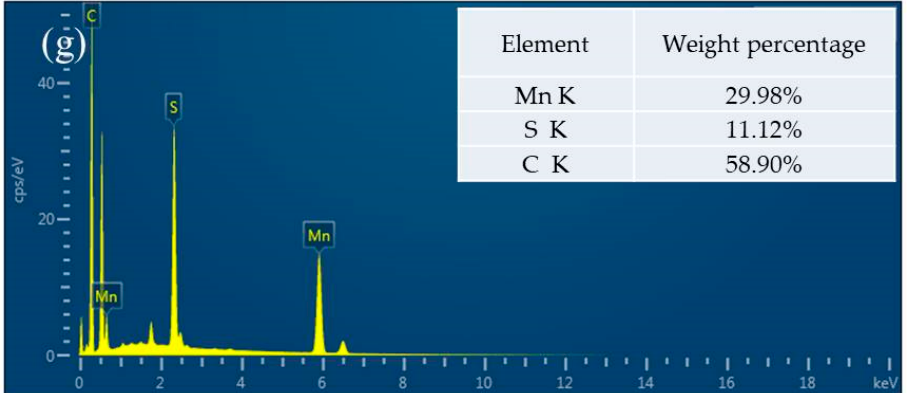
Figure 3. SEM images of ( a ) GO, ( b ) S1, ( c ) S2, ( d ) S3, ( e ) S4, and ( f ) S5. ( g ) EDS spectra of graphene- γ MnS.